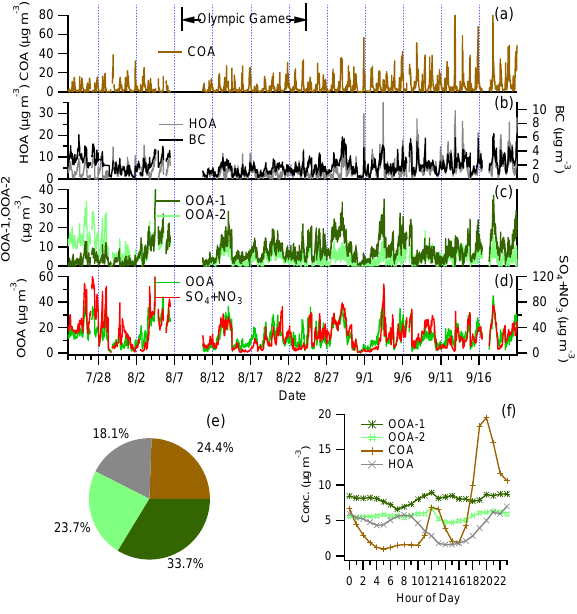
Fig. 4. Time series of (a–d) the OA components and other relevant species, (e) the average OA component contributions, and (f) the diurnal variations.